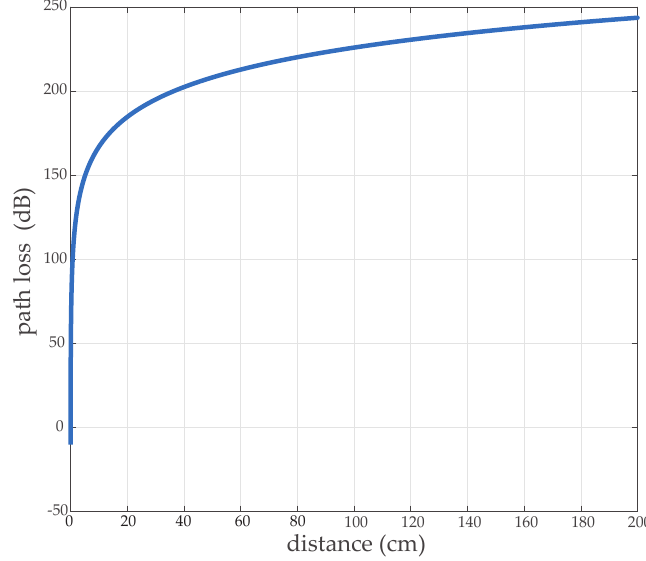
Figure 4. Path Loss for typical wireless body sensor network (WBSN)